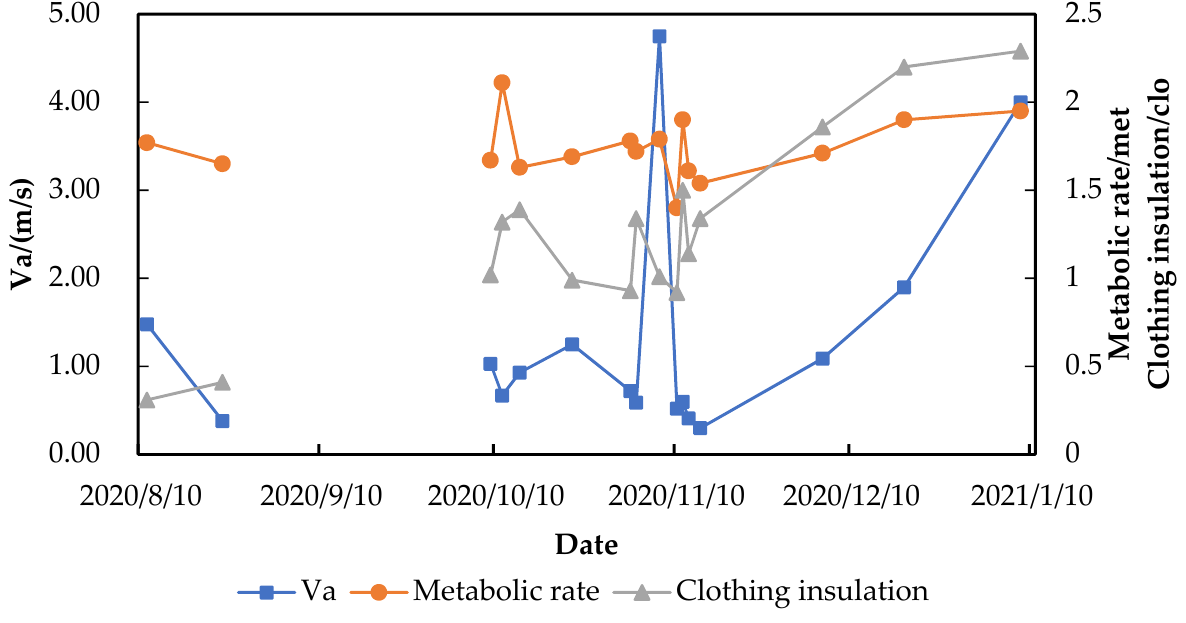
Figure 10. Metabolic rate, clothing insulation, and average wind speed in the square.